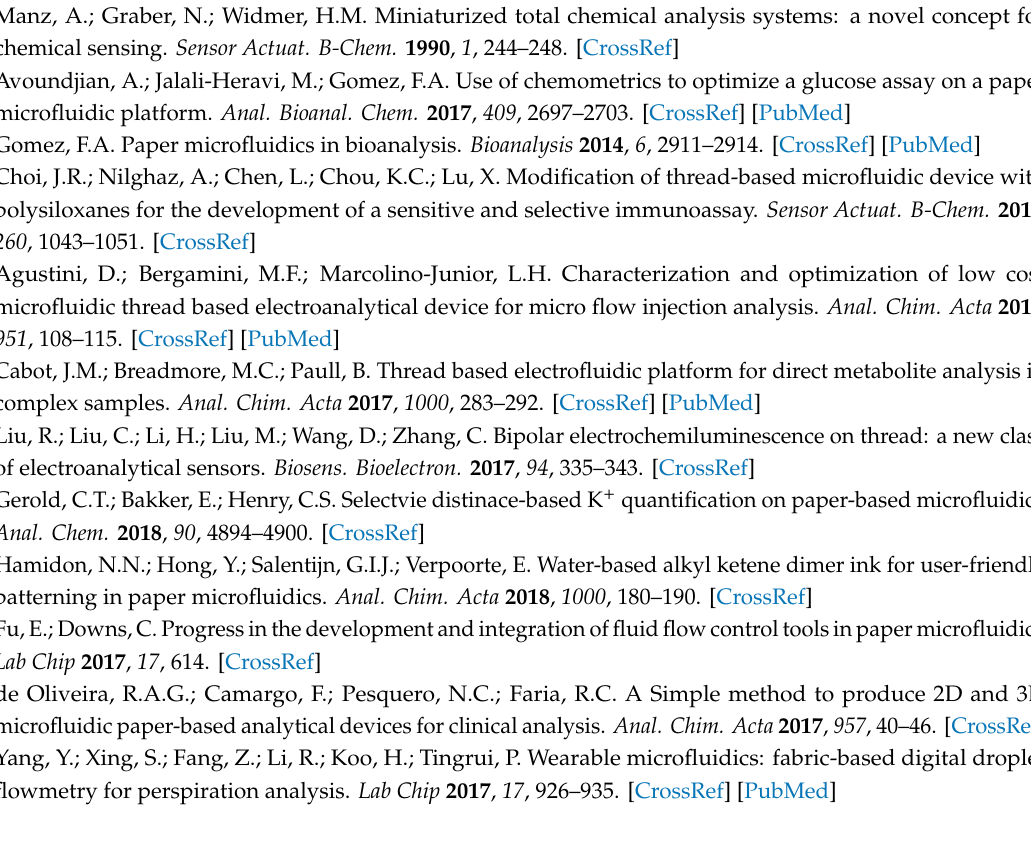
Table S1: Reagents and reaction wait times for the detection of goat anti-mouse IgG antibody using the µ CAD platform as a POC device. Table S2: Reagents and reaction wait times for the detection of rabbit IgG antibody using the µ CAD platform as a POC device. Table S3: Reagents and reaction wait times for the detection of glucose using the µ CAD